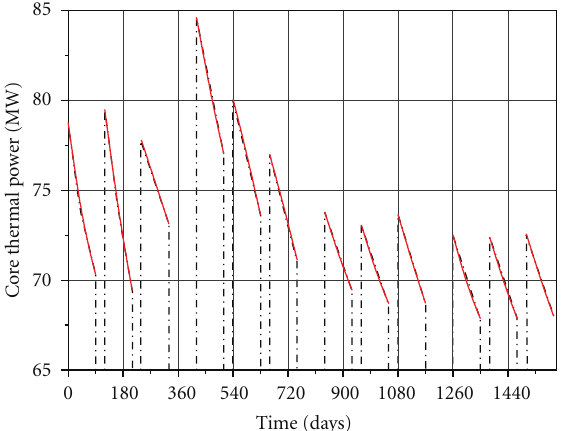
Figure 5: Evolution of total thermal power release.